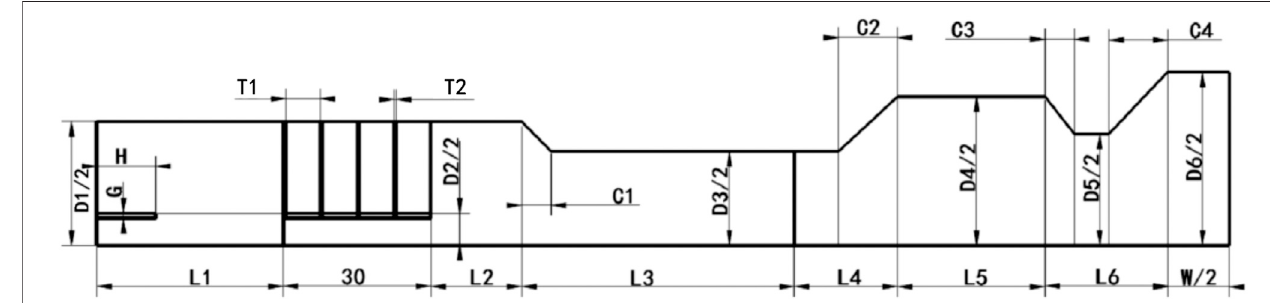
FIGURE 9 | Parameter diagram of quarter section model of piezoelectric vibrator.